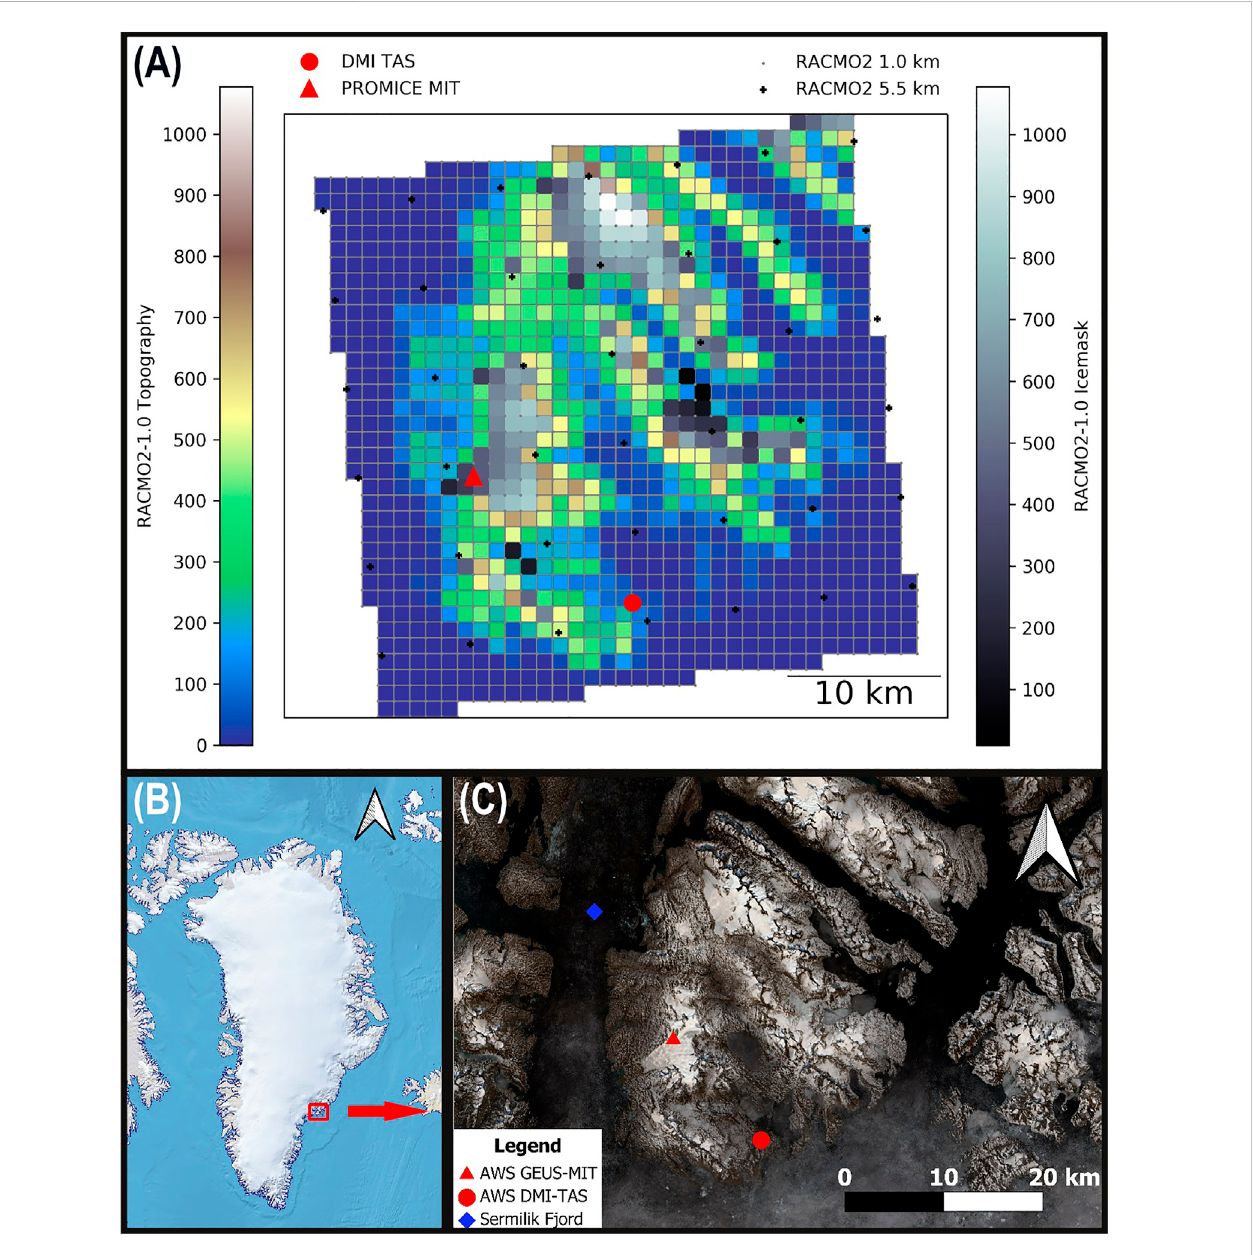
FIGURE 1 (A) The spatial resolution of both RACMO2 products is indicated with black (RACMO2-5.5km) and grey (RACMO2-1.0 km) dots. RACMO2-1.0 km model topography and Icemask as well as the location of AWS at Tasiilaq (DMI-TAS) and Mittivakkat (GEUS-MIT) are shown. (B) The location of the study area in Greenland. (C) Median of Sentinel 2 RGB imagery from July 2022 with highlighted locations of AWS GEUS-MIT, AWS DMI-TAS and the Sermilik